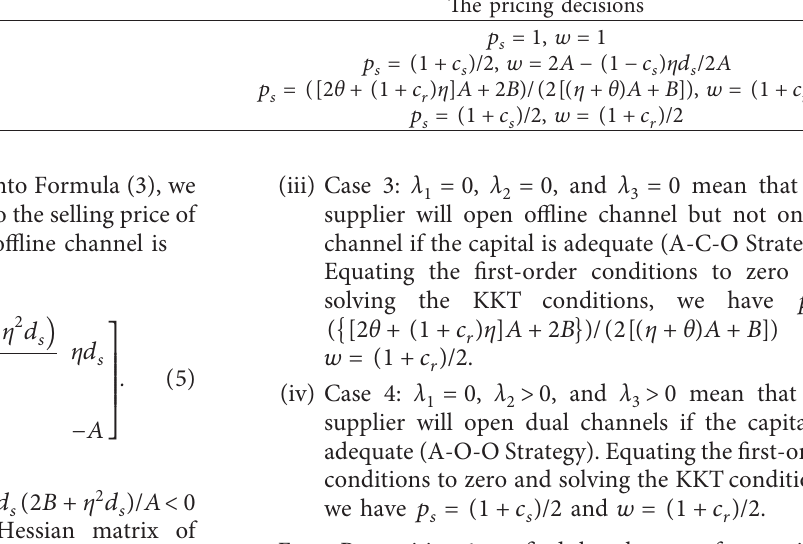
Table 2: The optimal strategy and pricing decisions with adequate capital constraint. The channel